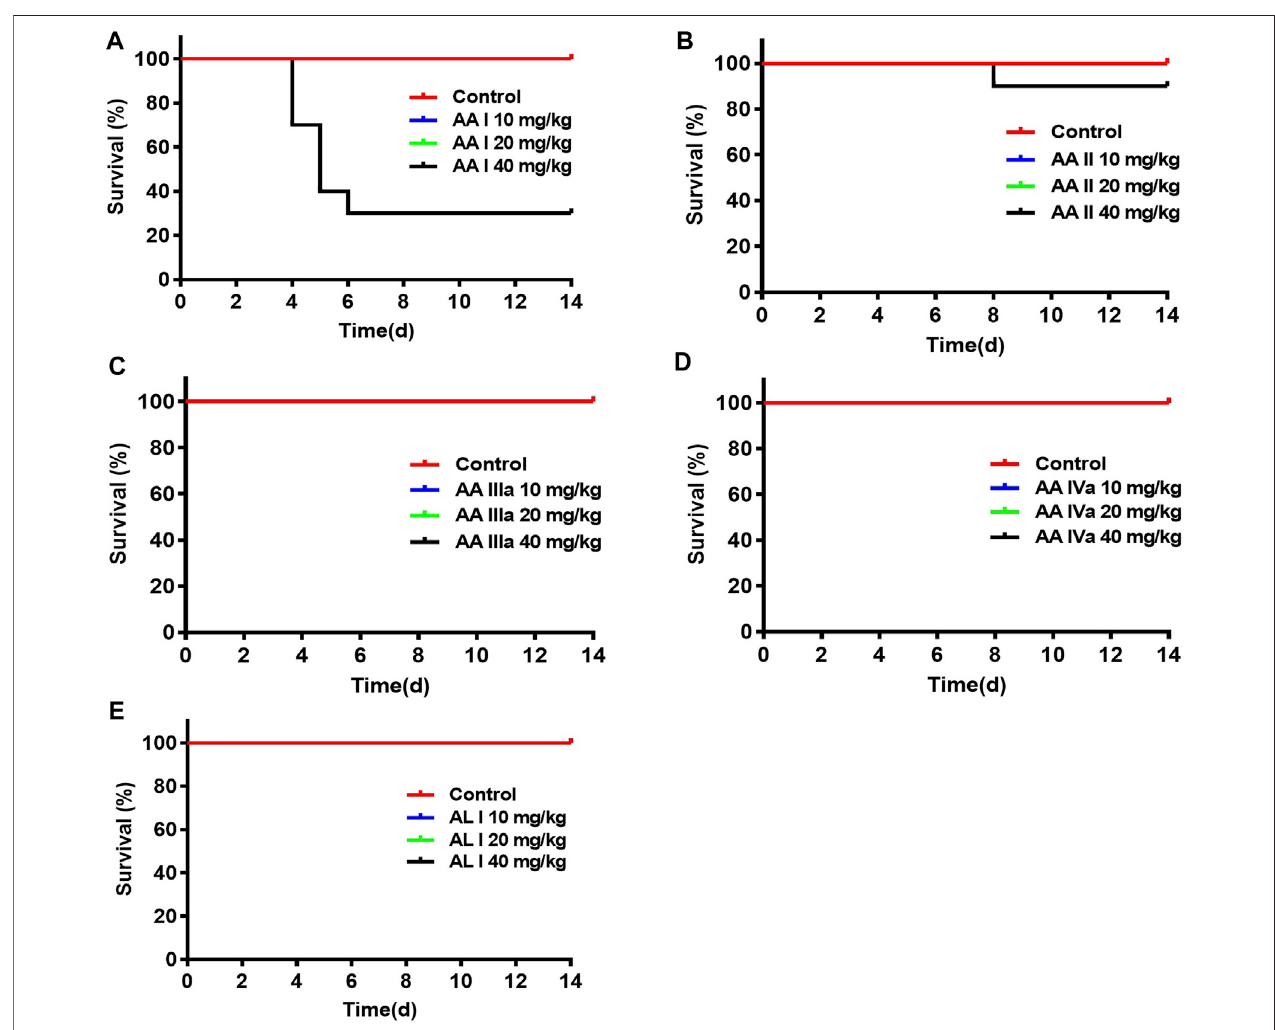
FIGURE3| Survivalsofmiceadministeredwitharistolochicacidanalogues:AAI (A) ,AAII (B) ,AAIIIa (C) ,AAIVa (D) ,andALI (E) .ICRmicewereadministeredwith aristolochic acid analogues at concentrations of 10, 20, and 40 mg/kg ( n (cid:2) 10 for each group). The curves were created by GraphPad Prism 7.0.